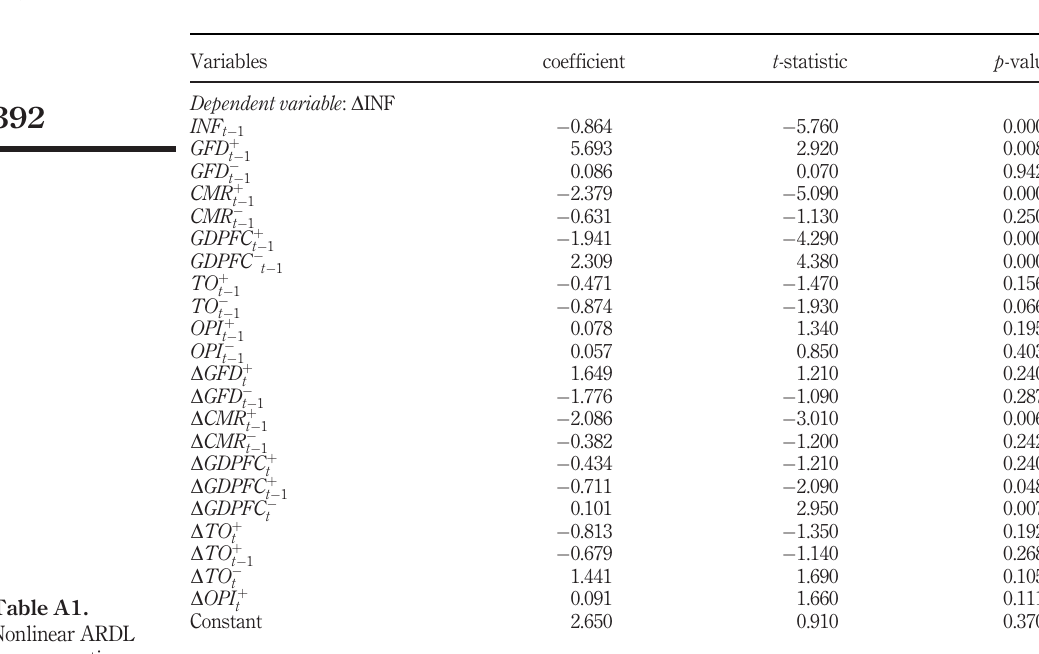
Table A1. Nonlinear ARDL error correction Model